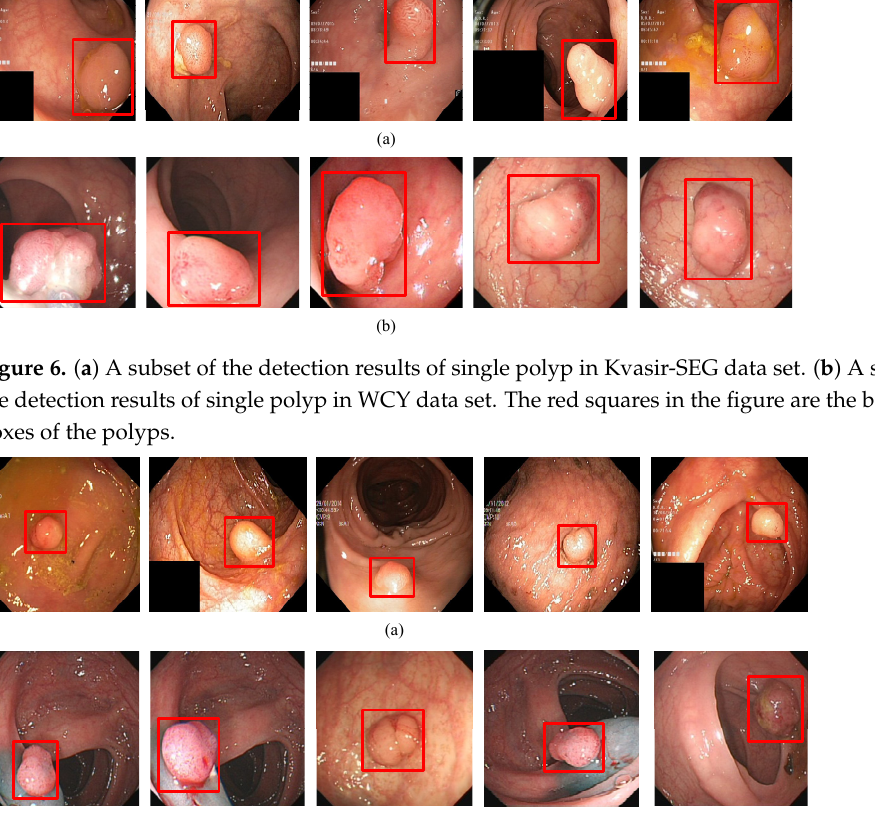
Figure 7. ( a ) A subset of the detection results of small target polyps in Kvasir-SEG data set. ( b ) A subset of the detection results of small target polyps in WCY data set. The red squares in the figure are the bounding boxes of the polyps.